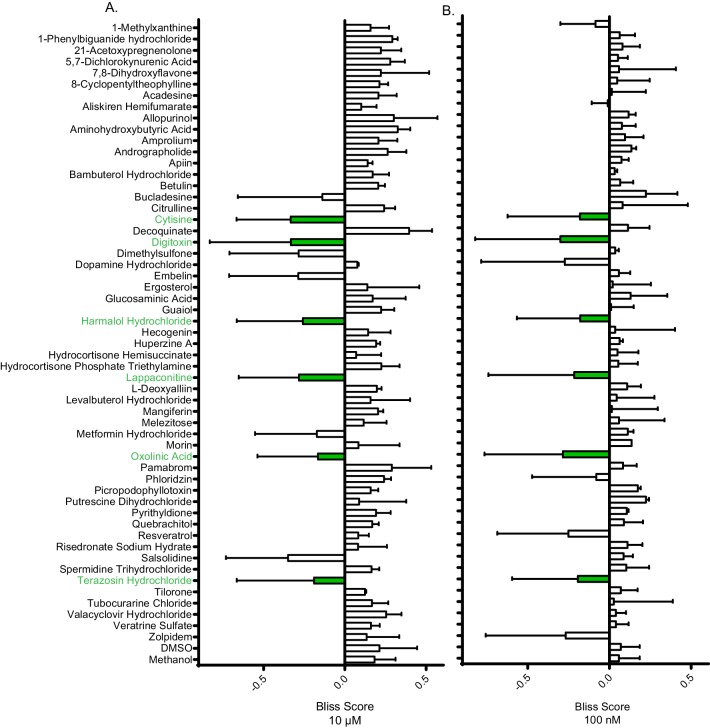
Bliss independence scores of non-single agent molecules.Average bliss independence score of molecules at (A) 10 µM and (B) 100 nM. Molecules were considered synergistic if they exhibited a negative score in both concentrations the majority of times tested (green labels). Average scores represent a minimum of two independent replicates. Error bars represent the standard deviation. Source data are in Figure 2—source data 3.